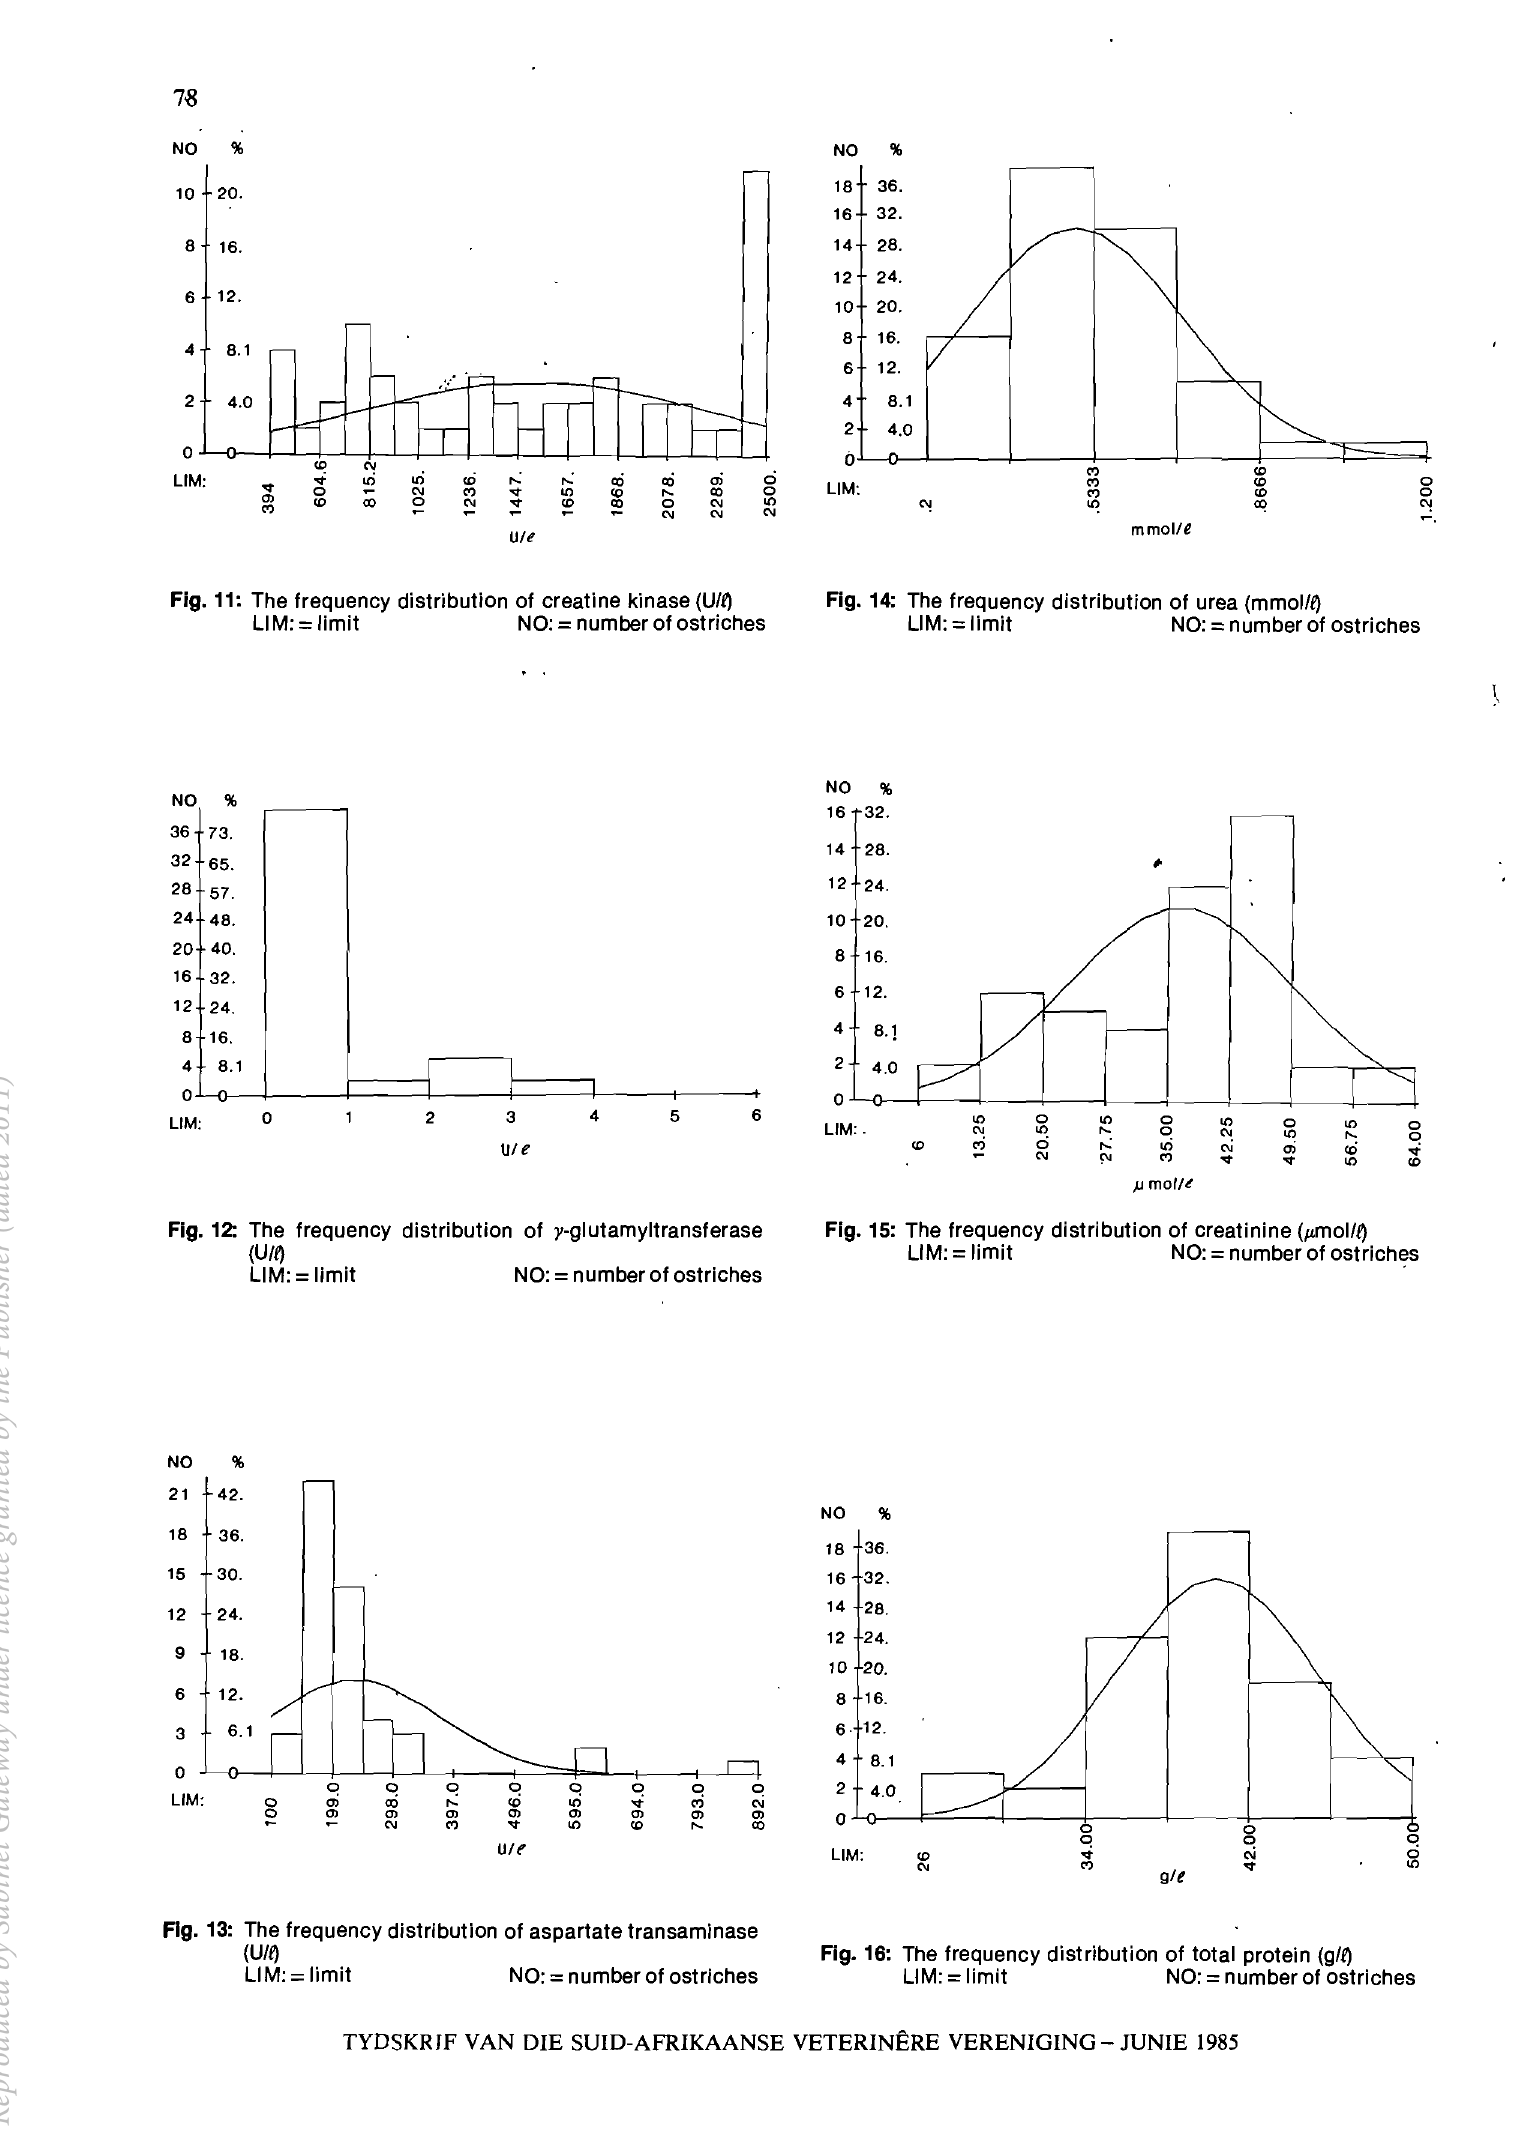
Fig. 16: The frequency distribution of total protein (gft) = = LIM: limit NO: number of ostriches